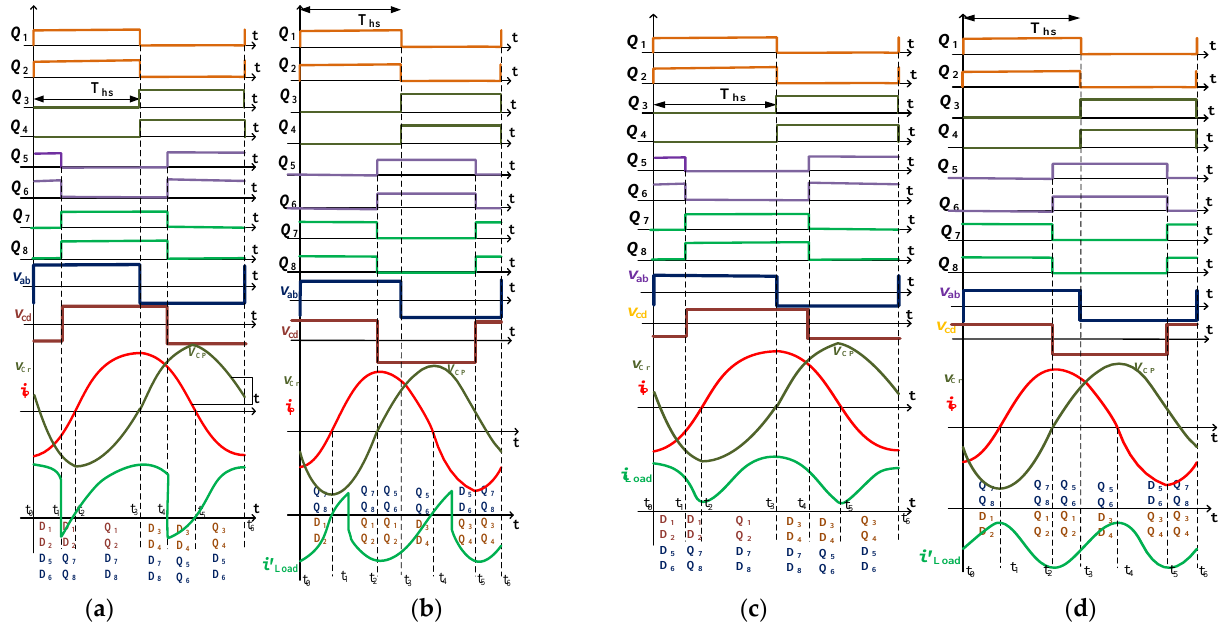
Figure 3. Model waveforms for voltage DAB converter ( a ) Forward mode ( b ) Reverse Mode and Current-fed converter ( c ) Forward mode ( d ) Reverse Mode. For the CFIBDC converter, a single-phase shift control (SPS) control technique is ap- plied. This technique is the simplest and most-preferred technique for isolated bidirectional dual active-bridge converters. In this technique, diagonal switch pairs in two bridges are turned ON to produce square waveforms having a 50% duty cycle for the respective switches. The square waveforms on either side of the isolation transformer have a phase difference; the leading voltage-side bridge delivers the power to the lagging voltage-bridge side of the transformer. Only a phase-shift ratio (or angle) ‘ ϕ ’ is chosen as the freedom of control; adjusting ‘ ϕ ’ allows power between the bridges to be controlled [33]. The various operation intervals in the converter’s forward and reverse modes of operation are described in the following subsections. The equivalent circuits during the forward and reverse modes of operation are shown in Figure